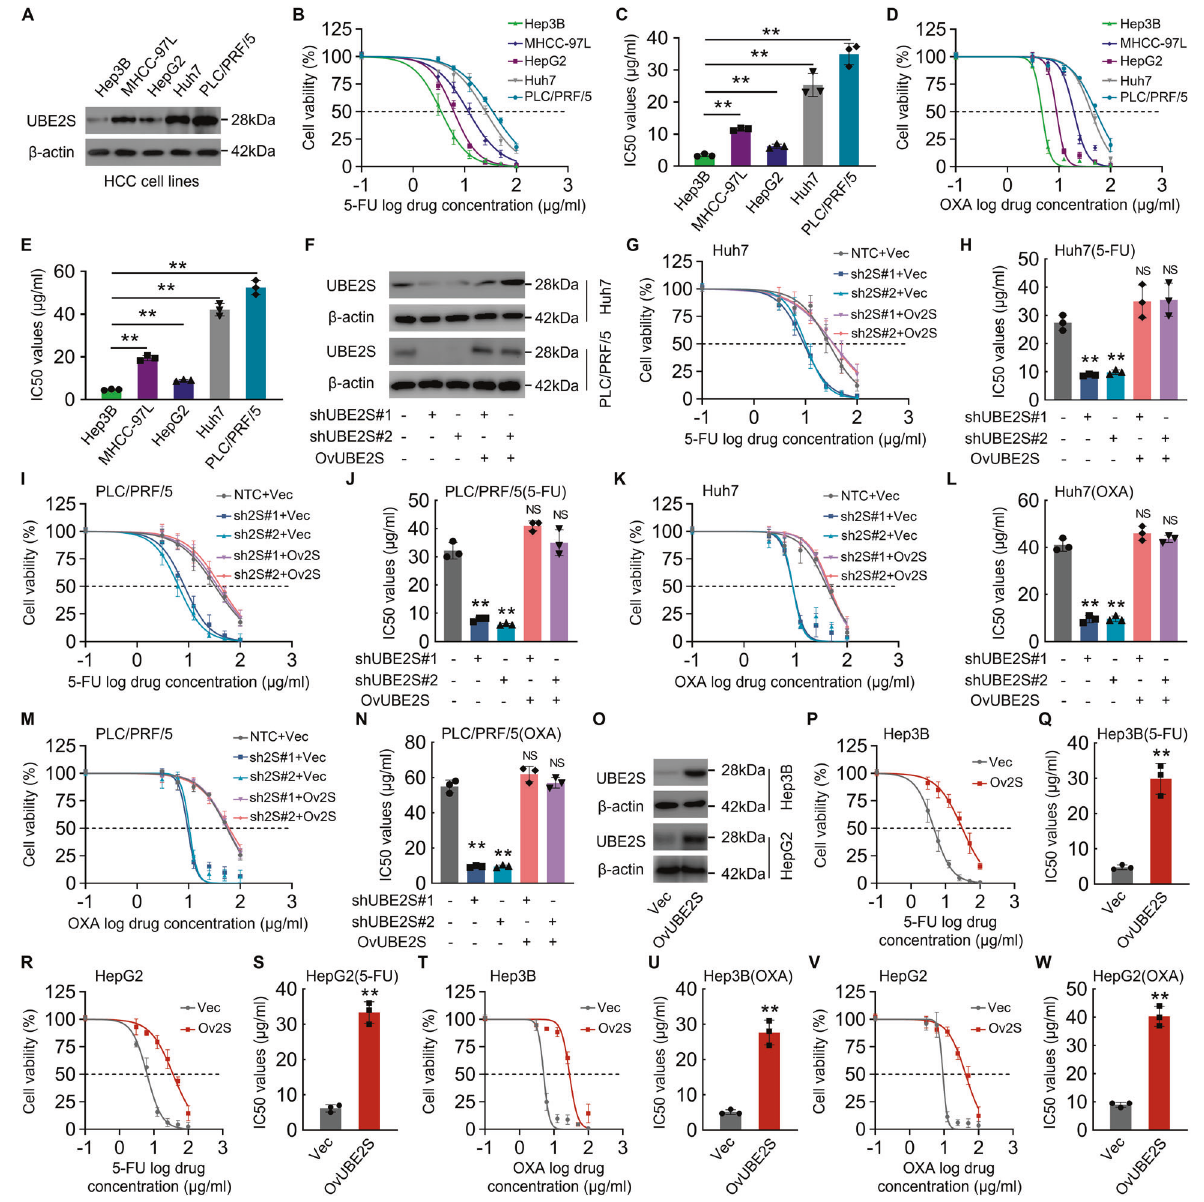
Fig. 2 UBE2S enhances resistance of HCC cells to 5-FU and oxaliplatin. A UBE2S protein levels in fi ve HCC cell lines were determined by western blot. B – E Cytotoxicity curves show the cytotoxic effects of 5-FU ( B ) and oxaliplatin ( D ) on fi ve different HCC cell lines. Bar graphs ( C , E ) show the IC50 values of n = 3 independent experiments. F UBE2S knockdown and overexpression rescue were validated by western blot in Huh7 and PLC/PRF/5 cells, respectively. G – J Cytotoxic effects of 5-FU on UBE2S-knockdown and UBE2S-rescue (knockdown